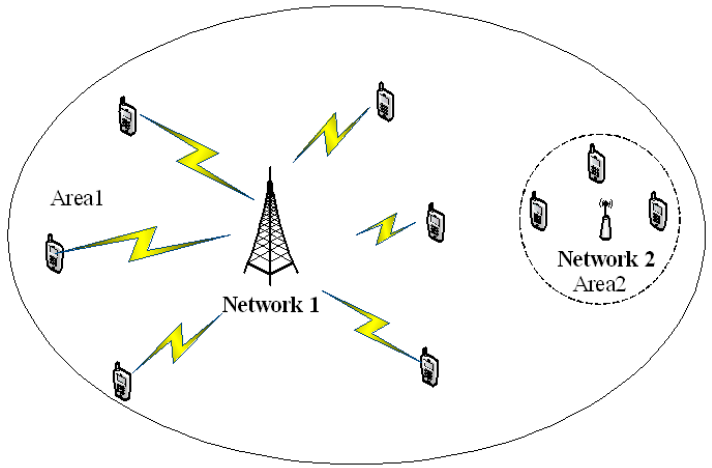
Figure 1. System model of the proposed mechanism.